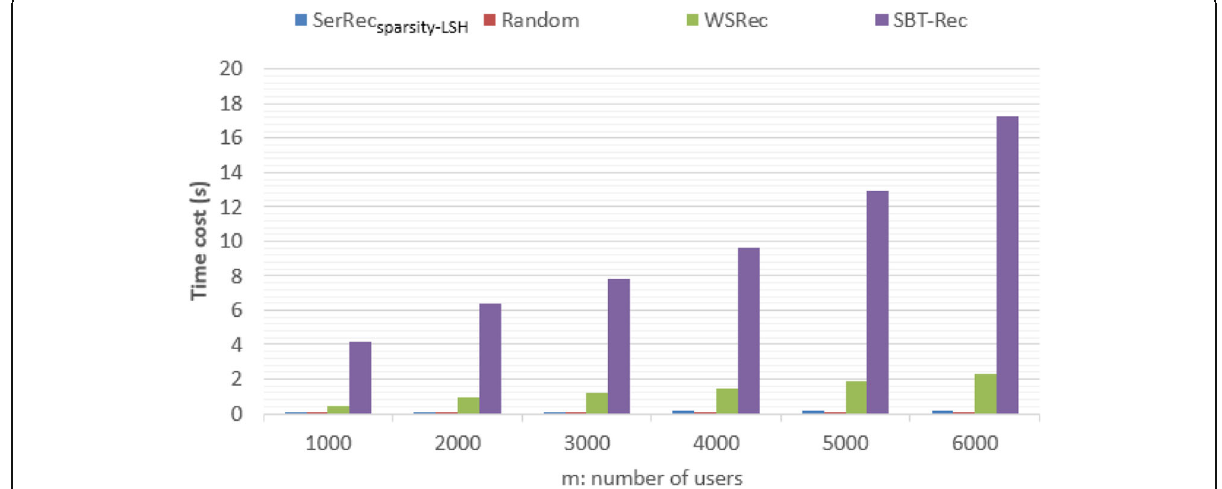
Fig. 5 Efficiency of the different